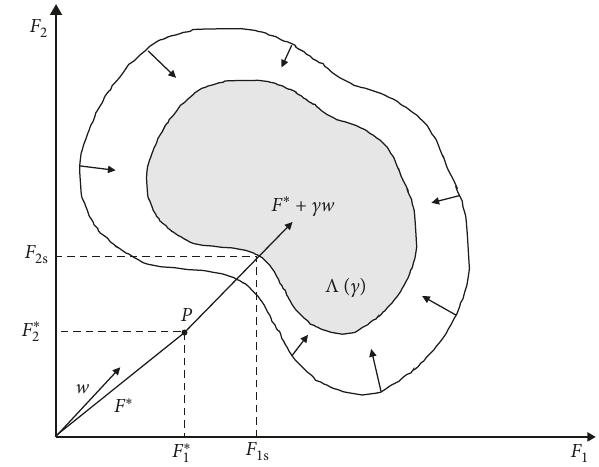
Figure 3: Goal attainment method with two objective